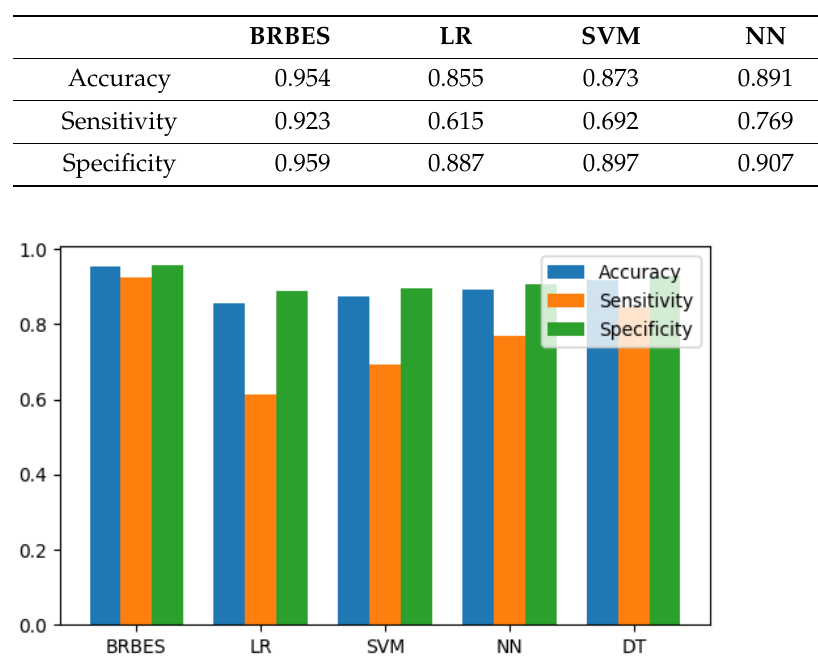
Table 11. Comparison among different machine learning algorithms.